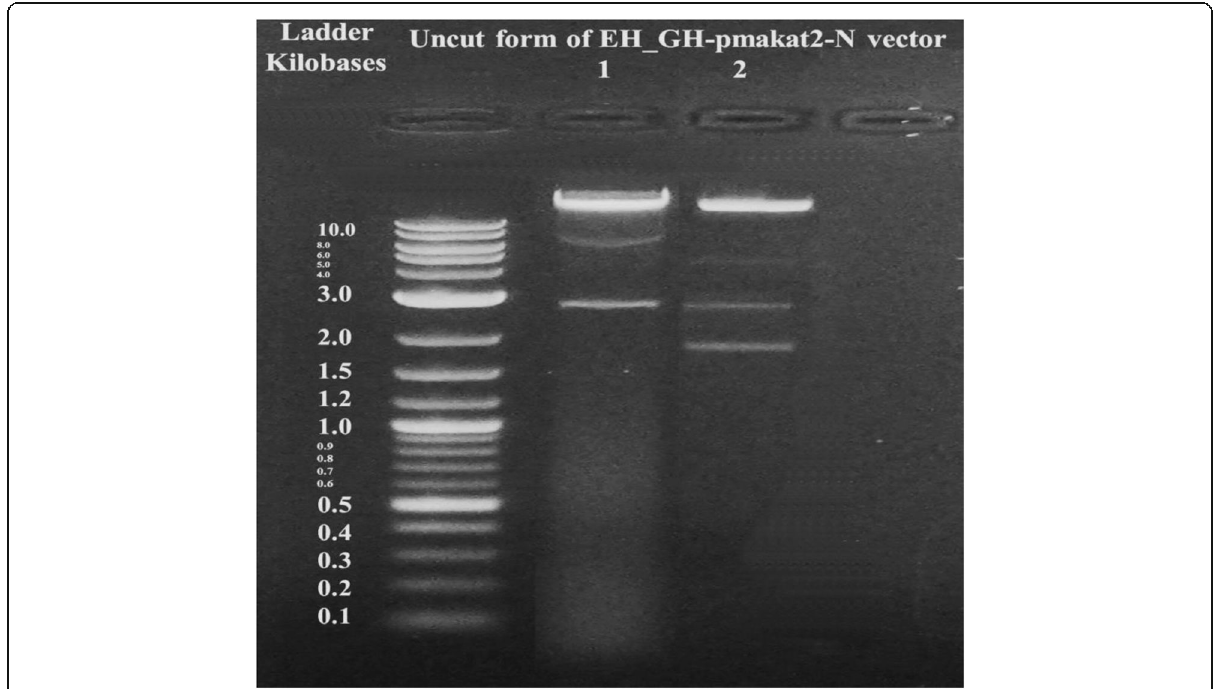
Fig. 3 Electrophoretic pattern of the uncut EH_GH – pmKate2 – N expression vector. Ladder, DNA marker (100 to 10,000 bp); 1 and 2 are the samples of the uncut EH_GH – pmKate2 – N expression